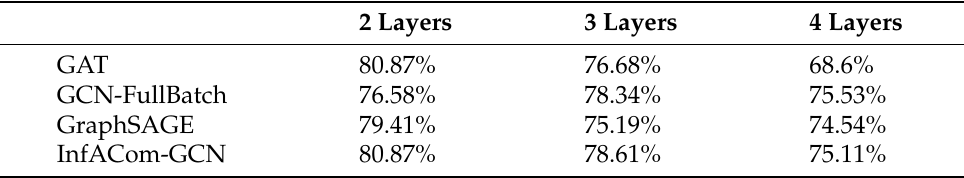
Table 10. Average accuracy of 50 epochs for PubMedDiabetes dataset using 2, 3, and 4 layers (the number of hidden units is